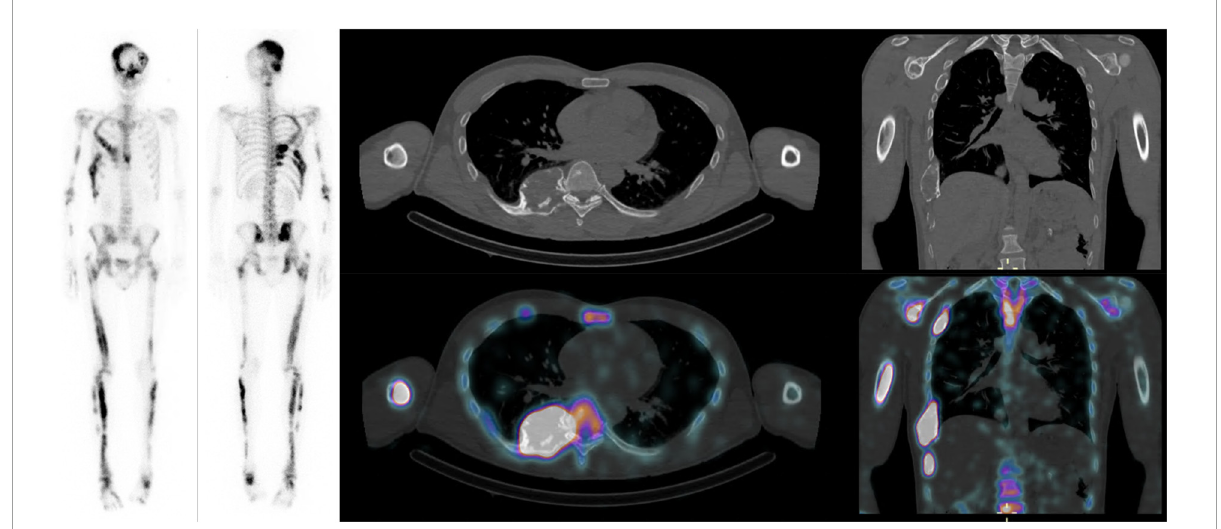
FIGURE1 Forty-year-old male patient with Mazabraud syndrome: Mean SUV max and SUV mean of 11 and 6.7 g/mL, respectively. SBS: 46.3, FGF-23: 175 (10–50 pg/mL), CTX: 531 pg/mL, P1NP: 383 (15–78 µ g/L), ALP: 277 (36–108) U/L, scoliosis angle: 11 degrees.